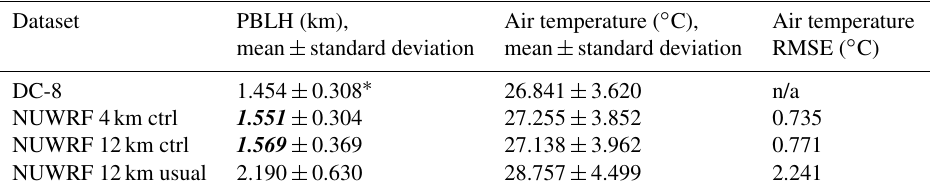
Table 2. NUWRF PBLH and air temperature performance along the DC-8 flight path (at where the isoprene data are available) around the Missouri isoprene volcano region on 11 September 2013. A 1.6km PBLH, which approximates to the 4 and 12km simulated mean values (in bold italics), was used to derive the emissions. Spatial distribution of the air temperature biases is shown in Fig. S3. Control is denoted by ctrl. Dataset PBLH (km), Air temperature ( ◦ C), Air temperature mean ± standard deviation mean ± standard deviation RMSE ( ◦ C) DC-8 1.454 ± 0.308 ∗ 26.841 ± 3.620 NUWRF 4km ctrl 1.551 ±